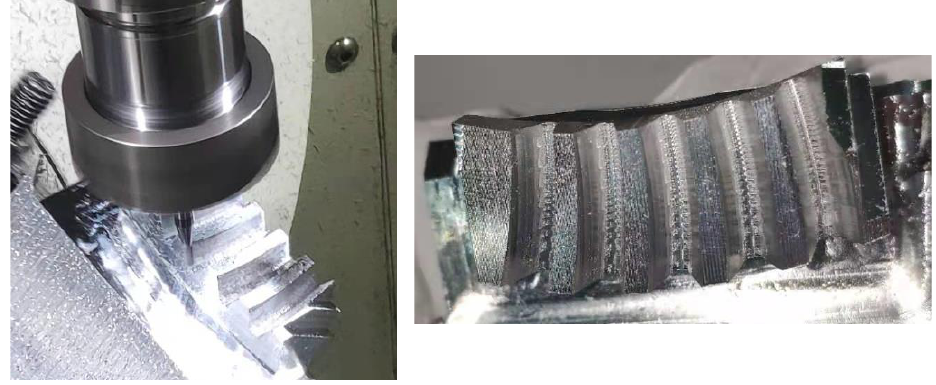
Figure 12. Five-axis flank milling of